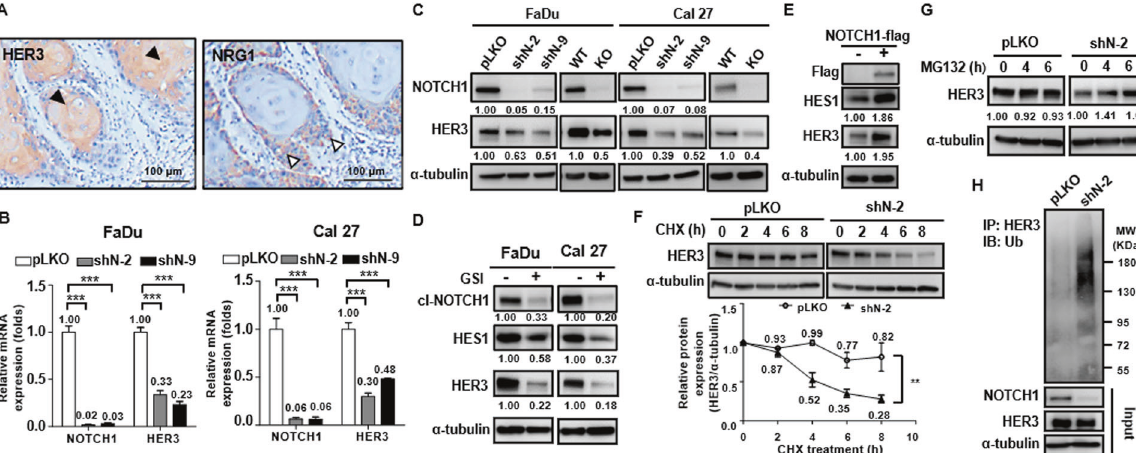
Fig. 1 HER3 is preferentially expressed in differentiated tumor cells and inhibition of NOTCH1 suppresses HER3 mRNA and destabilizes HER3 protein in SCCHN. A The majority of HER3-positive cells were differentiated cells in the center of the in fi ltrating tumor nests (black arrowhead, membranous stain of HER3), while the signal for NRG1 was primarily found in basaloid cells at the periphery of the tumor nests (white arrowhead, cytoplasmic stain of NRG1). B The mRNA level of HER3 was drastically reduced in FaDu and Cal 27 cells after NOTCH1 silencing with different lentivirus-expressed shRNAs, when compared to control shRNA (pLKO, as the baseline of normalization). Column: the average relative expression, compared to the pLKO group ± standard error ( n = 3). *** p < 0.001 by two-way ANOVA. C The protein level of HER3 was also greatly reduced in FaDu and Cal 27 cells after NOTCH1 silencing with different shRNAs or knockout with a CRISPR-Cas9 system. D The expression of HER3 was signi fi cantly decreased after NOTCH1 signaling was inhibited with the treatment of a γ -secretase inhibitor (GSI) for 24 h in SCCHN cells (FaDu, 50 μ M; Cal 27, 20 μ M). cl-NOTCH1, cleaved NOTCH1; HES1, a known downstream component of NOTCH1 pathway that serves as an indicator of NOTCH1 signaling. E Conversely, overexpression of NOTCH1 protein ef fi ciently increased the expression of HES1 and HER3. F The protein stability assay revealed a steep decrease of HER3 protein and a lower residual protein quantity in NOTCH1-knockdown FaDu cells compared to controls (28% vs. 82% at 8 h) after inhibition of translational activity